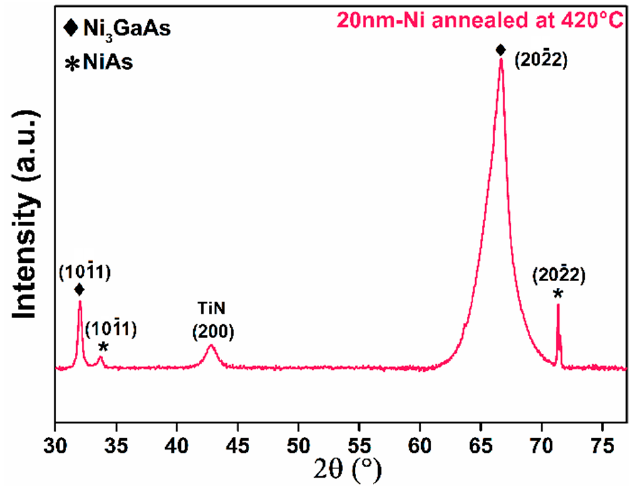
Figure 5. Ex situ XRD diffractogram for 20-nm-thick Ni sample annealed at 420 °C.